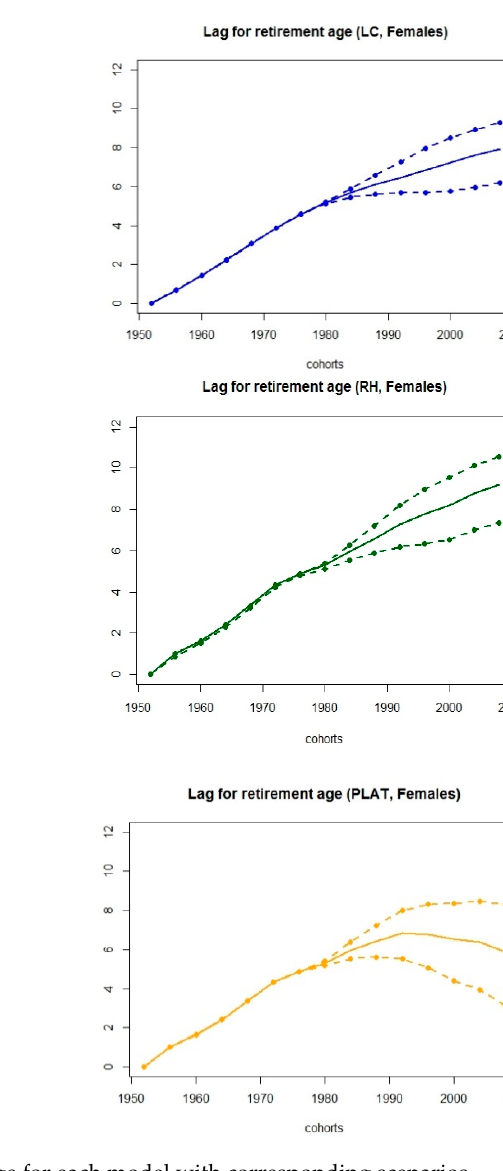
Figure 7. Lags for indexed retirement age for each model with corresponding scenarios.